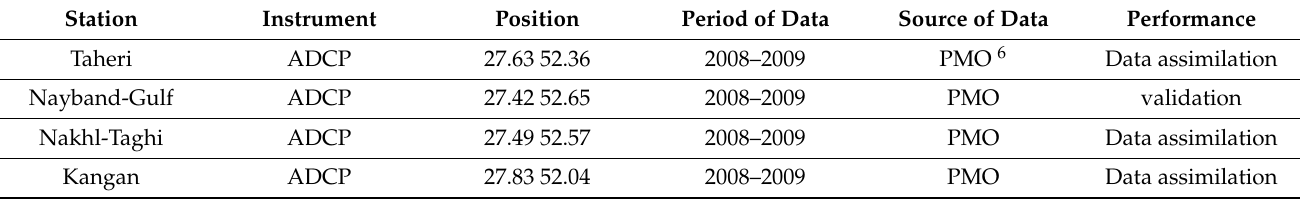
Table 2. Specifications of current meter